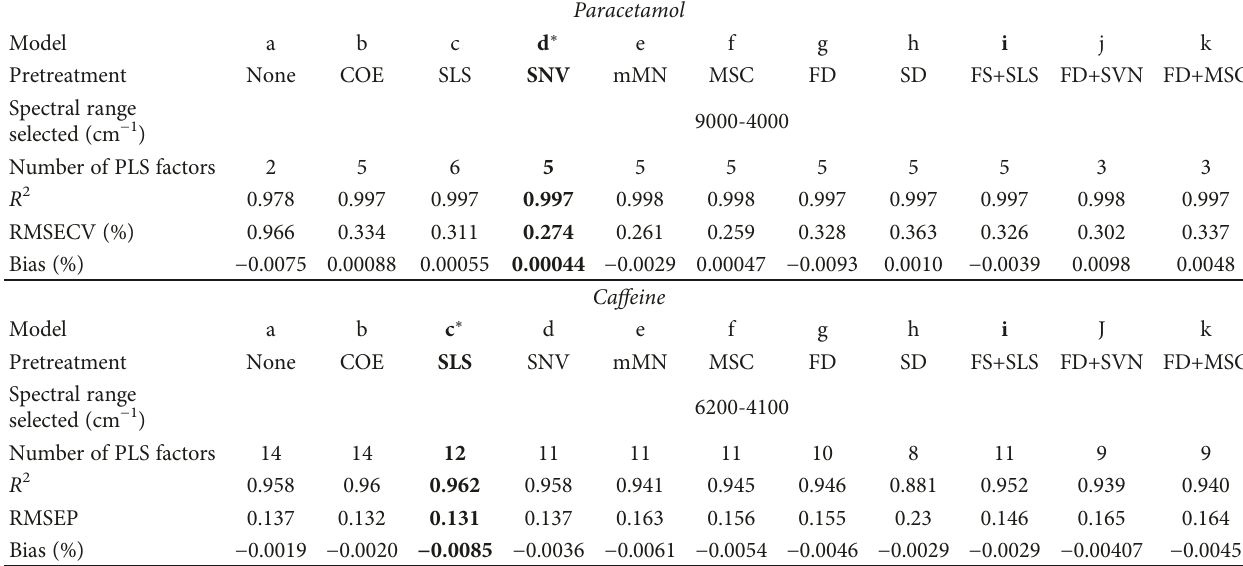
Table 3: Statistical parameters and number of PLS factors for di ff erent models proposed for paracetamol and ca ff eine assays in powder blends.